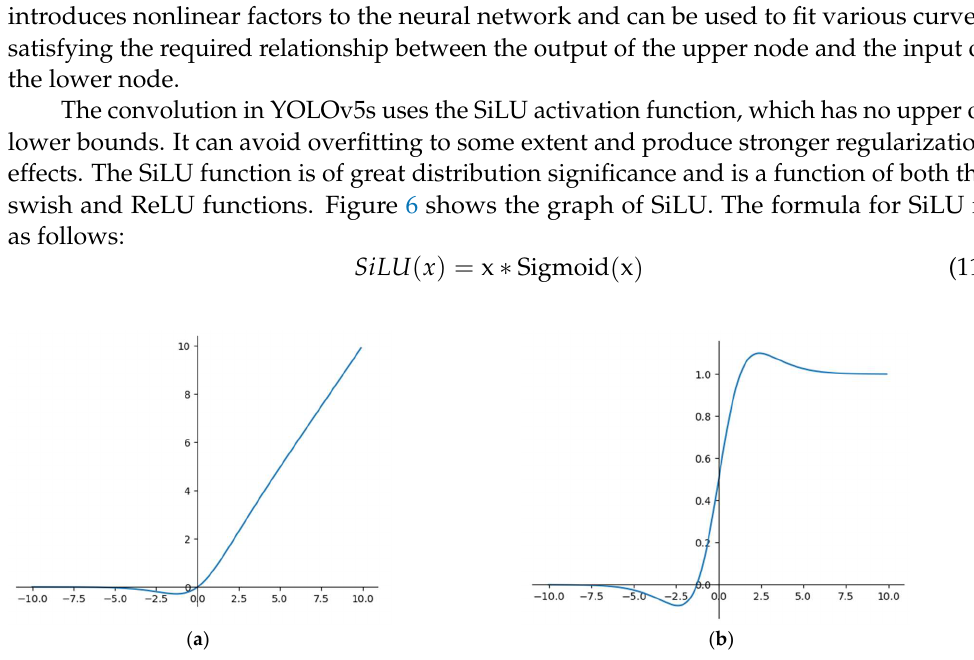
Figure 6. The graph of SiLU: ( a ) is the SiLU function graph; ( b ) is the derivative SiLU function graph.